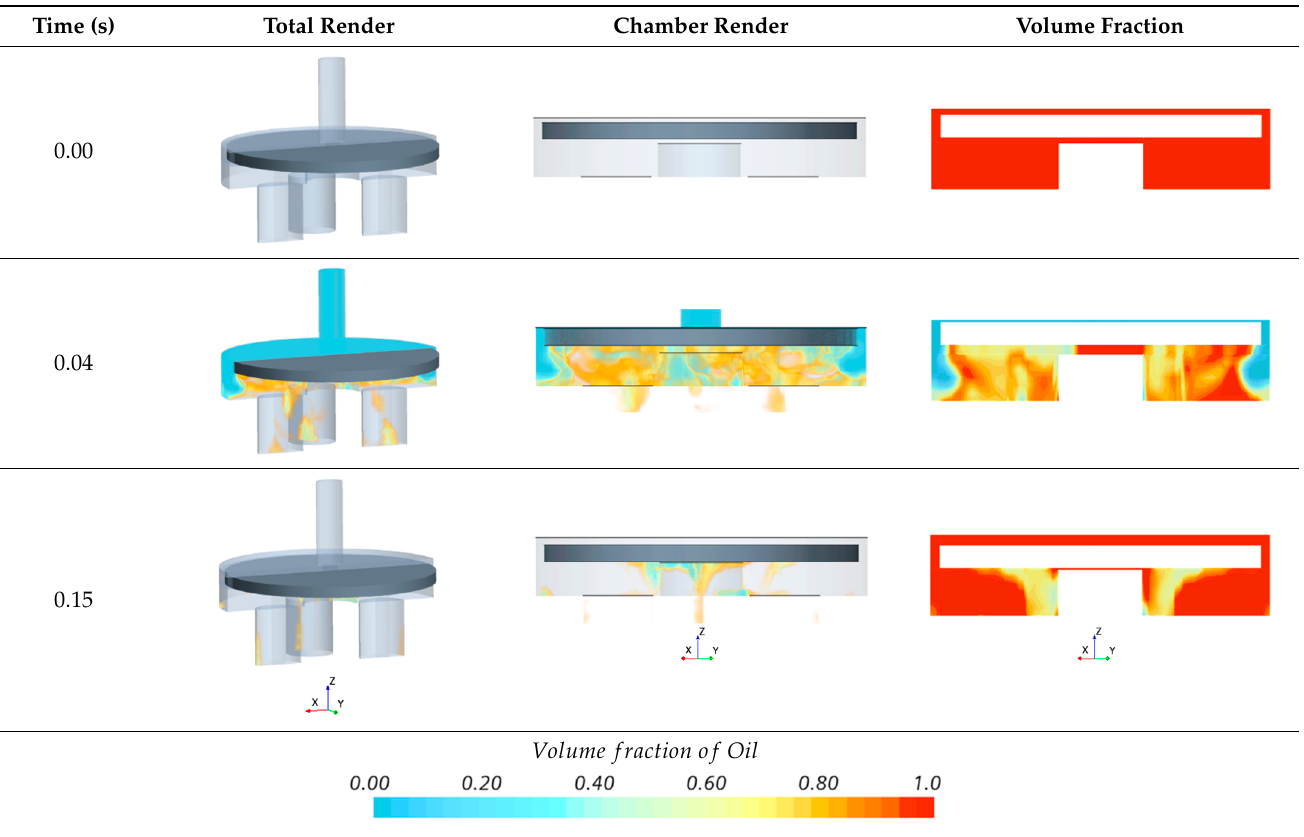
Table 3. Plate motion at different stages of the process.